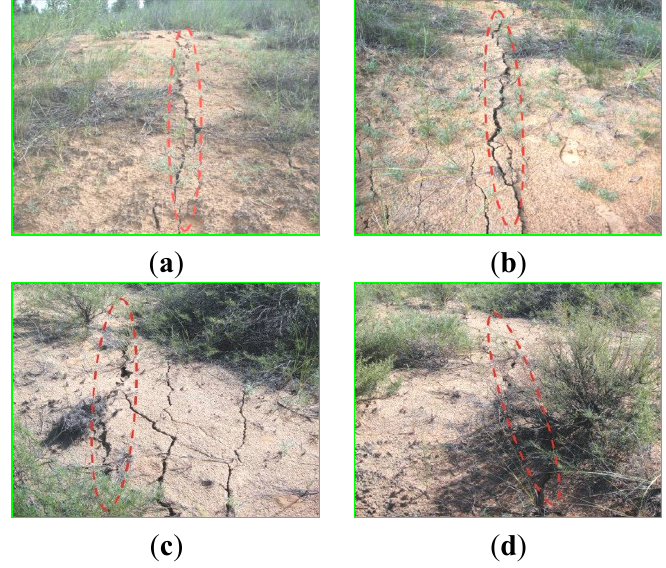
Figure 18. Through cracks on the surface during the periodic weightings: ( a ) the first periodic weighting; ( b ) the second periodic weighting; ( c ) the third periodic weighting; and ( d ) the fourth periodic weighting.